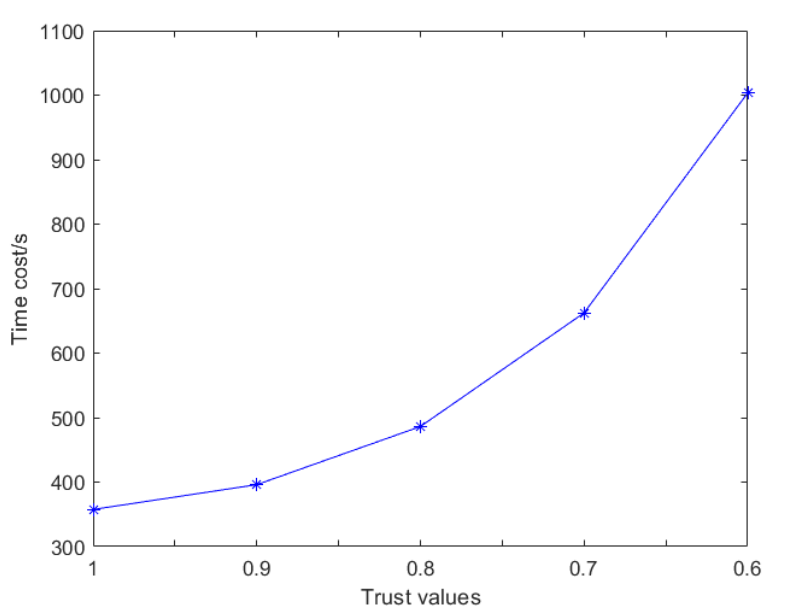
Figure 6. Service time based on different trust values.